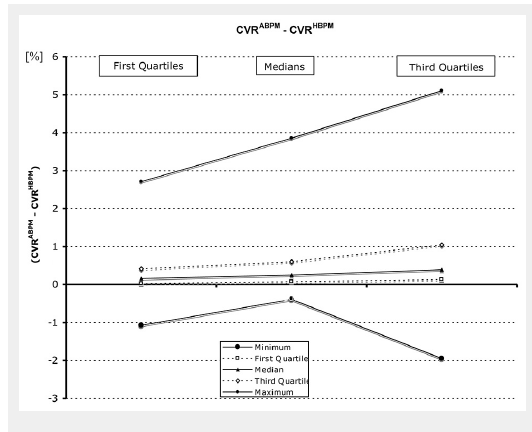
Figure 2 third quartile of all patients. ABPM = ambulant blood pressure measurement; CVR = cardiovascular risk; HPBM = home blood pressure